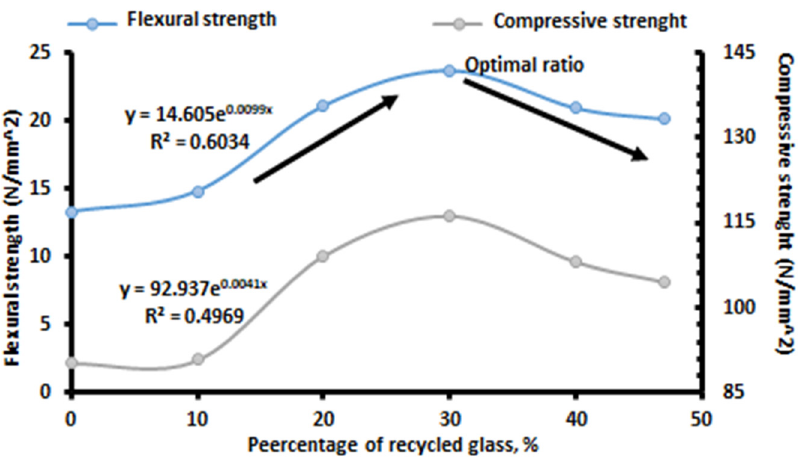
Figure 6. Flexural and compressive strength behavior of concrete samples with glass powder. Reprinted with permission from [51]. Copyright©2013, Elsevier B.V.